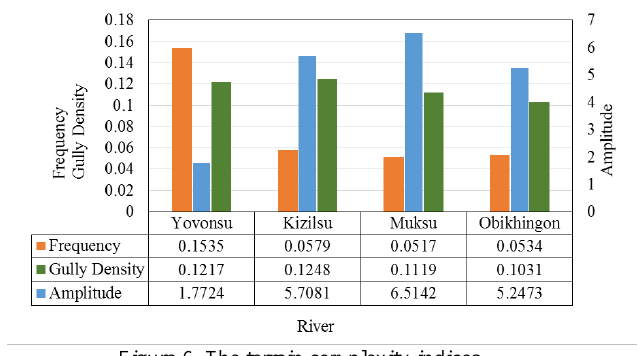
Figure 6. The terrain complexity indices 4.2.2 The Landform Development Analysis: The correlation between geomorphologic development and water erosion can be reflected quantitatively from different aspects by landform development indices. The indices of the four basins are shown in Figure 7. The longitudinal slope of the Yovonsu River is small because of stability and low terrain. And the Kizilsu River with large area has numerous tributaries so that the value is also small. Dissimilarly, the other two basins are located in the deep valleys and have large downcutting depth, so the longitudinal slope of them are large. The roundness rate is not only influenced by lithology, but also depends on the development degree of the basin and the total slope of the region. Judging from the entire Vakhsh River, the development of catchment is relatively mature. From the catchments of four tributaries, the development degree of the Yovonsu River and the Muksu River are lower than that of the Kizilsu River and the Obikhingon River. This is corresponding to the overall situation of the longitudinal valley profile